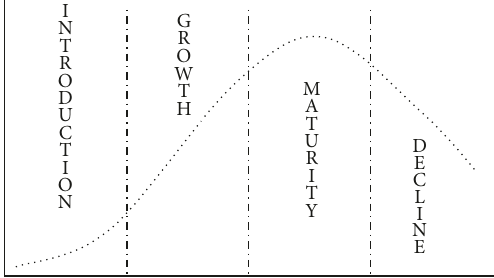
Figure 1: Industry life cycle